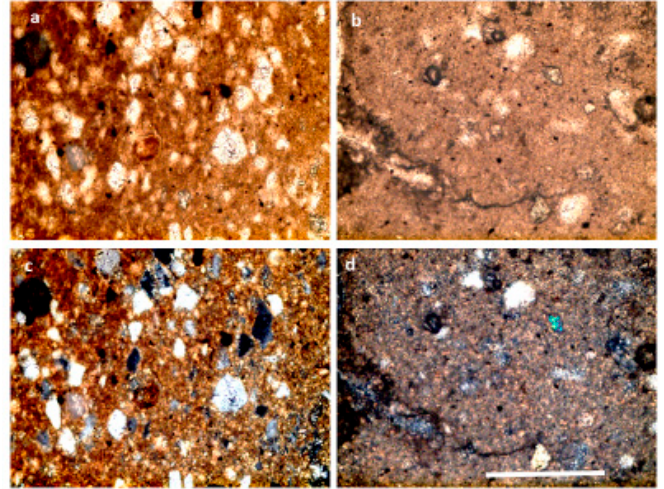
Figure 3. Optical light microscope images of samples 563 ( a , c ) and 570 ( b , d ). Plain polarized light was used for images a and b, and crossed polarized light for images c and d. The sand-sized large angular inclusions are mostly quartz. The fine-grained silt-sized matrix of 563 has abundant ferruginous material giving the sample a reddish dark color, whereas this ferruginous material is absent in 570. The fine-grained matrix is composed of calcite, which is birefringent, and clay minerals. The crack in sample 570 has been filled in with secondary calcite. All images are at the same magnification. Scale bar is 250 µ